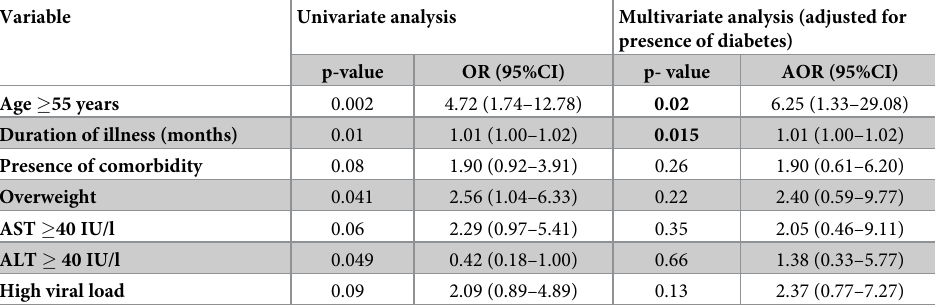
Table 10. Predictors of peripheral neuropathy in chronic hepatitis C